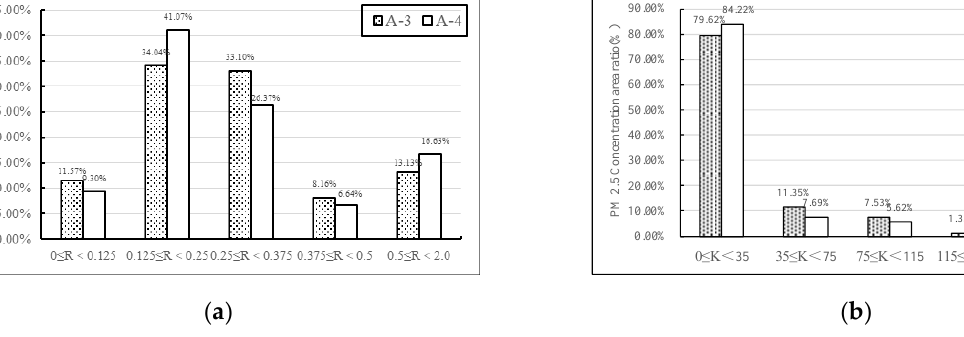
Figure 11. Column Analysis Chart: ( a ) air velocity area ratio of A-3 and A-4 kitchens. ( b ) PM2.5 concentration area ratio of A-3 and A-4 kitchens.